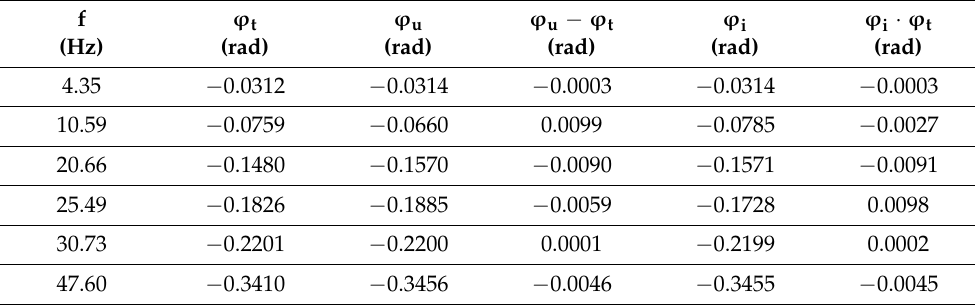
Table 3. Deviation in phase shift angle φ u( i ) between the input and output signals of the tested analog filter, determined by the suggested method, and the theoretical values φ t.